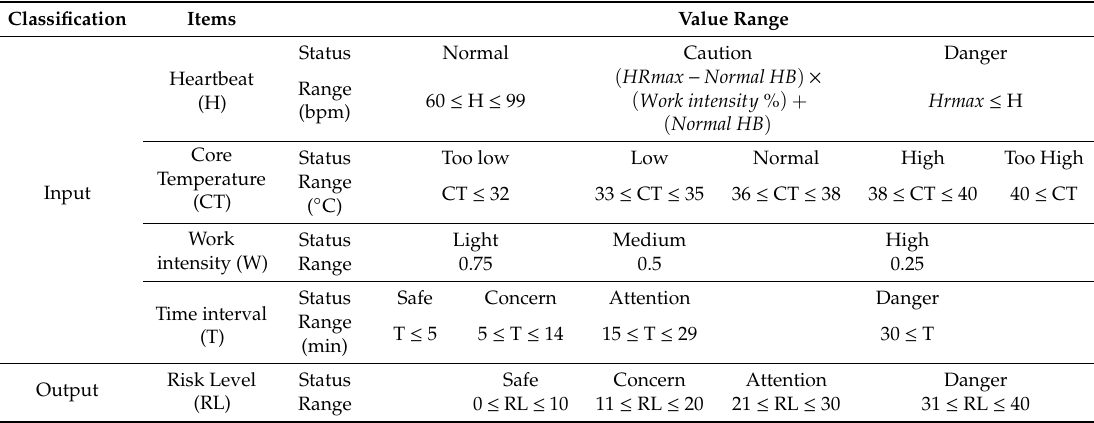
Figure 9. Fuzzy rule base. Table 5. Risk level evaluation items and